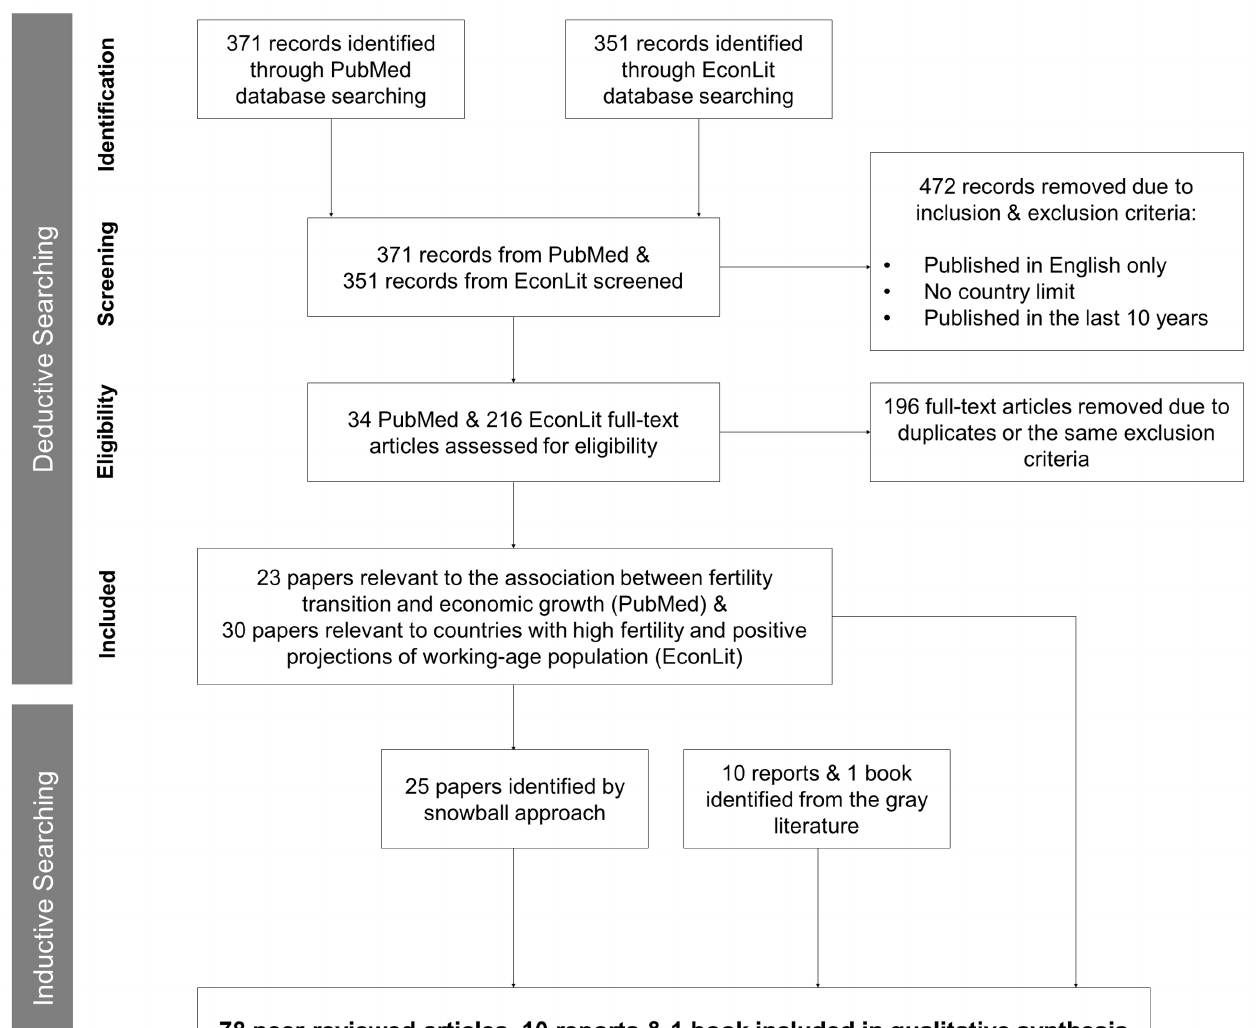
Figure 1. Flow of information through the different phases of the systematic